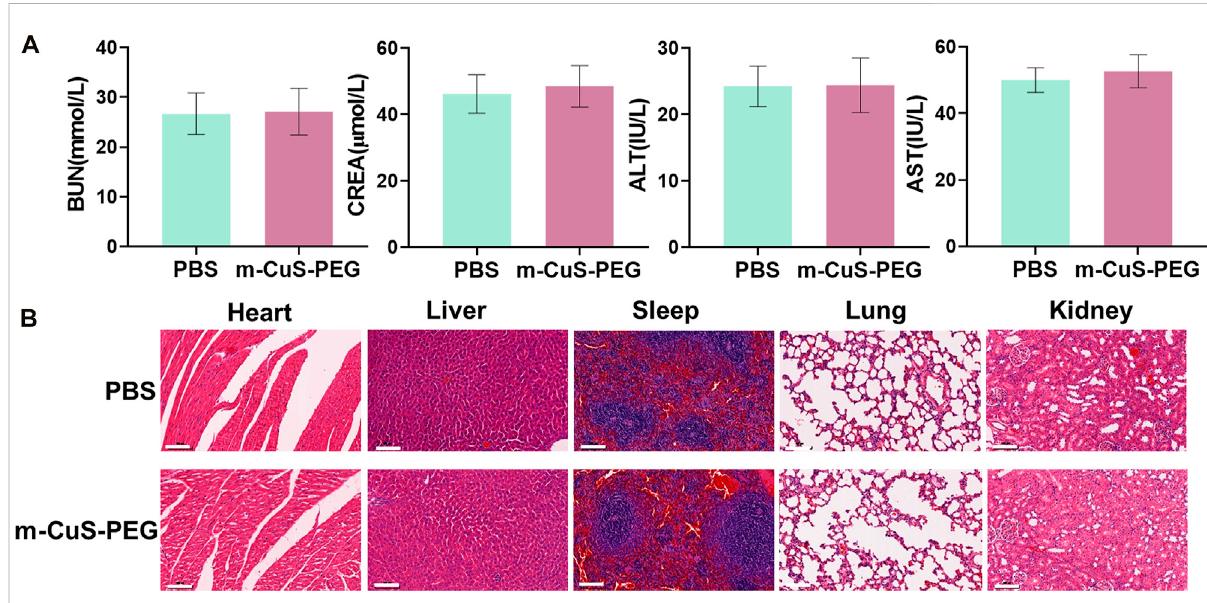
FIGURE 5 Biosafety of m-CuS-PEG. (A) Liver function (ALT, AST) and kidney (BUN, CREA) function of m-CuS-PEG. sample size: n = 3; (B) H&E staining images of mice major organs after PBS or m-CuS-PEG treatment. Scale bars = 100 μ m for H&E.